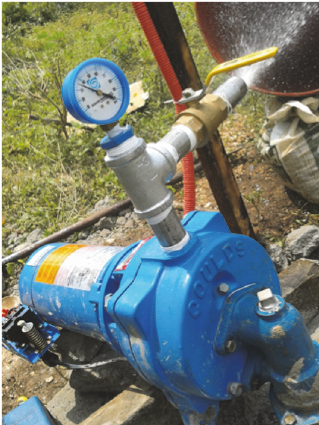
Figure 3: Water pump at work in Camotes farm, Cebu,